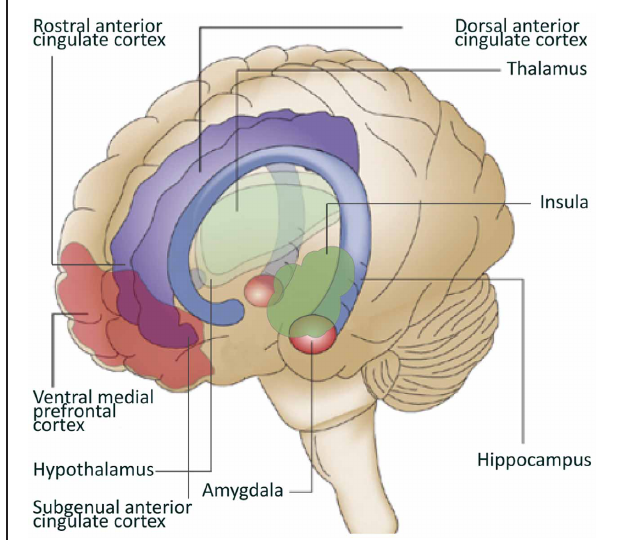
FIGURE 1 | Brain regions involved in resilience to stress. Depicted in this figure are brain regions often linked to resilience to stress. Adapted from Schloesser et al.